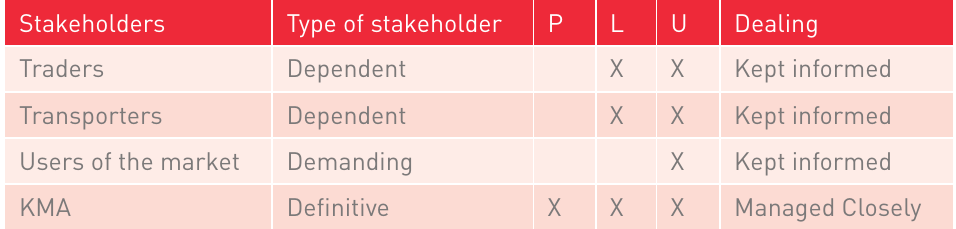
Table 2 Stakeholders of the Kumasi Central Market Redevelopment Stakeholders Type of stakeholder P L U Dealing Traders Dependent Kept informed Transporters Dependent Users of the market